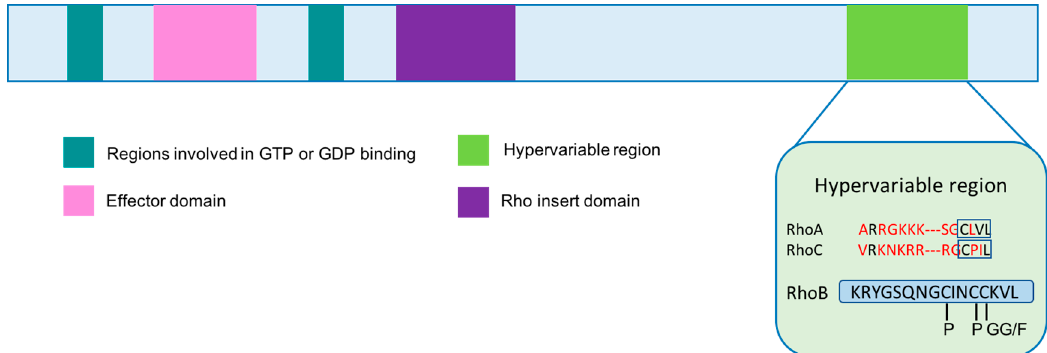
Figure 2. Rho GTPase domain organization. The differences between RhoA, RhoB and RhoC lie in the hypervariable region. Red amino acid residues indicate differences from RhoB sequence. RhoB can be palmitoylated, farnesylated and geranylgeranylated, where RhoA and RhoC can only be palmitoylated. P: palmitoylation; GG: geranylgeranylation; F: farnesylation. Adapted from [16].